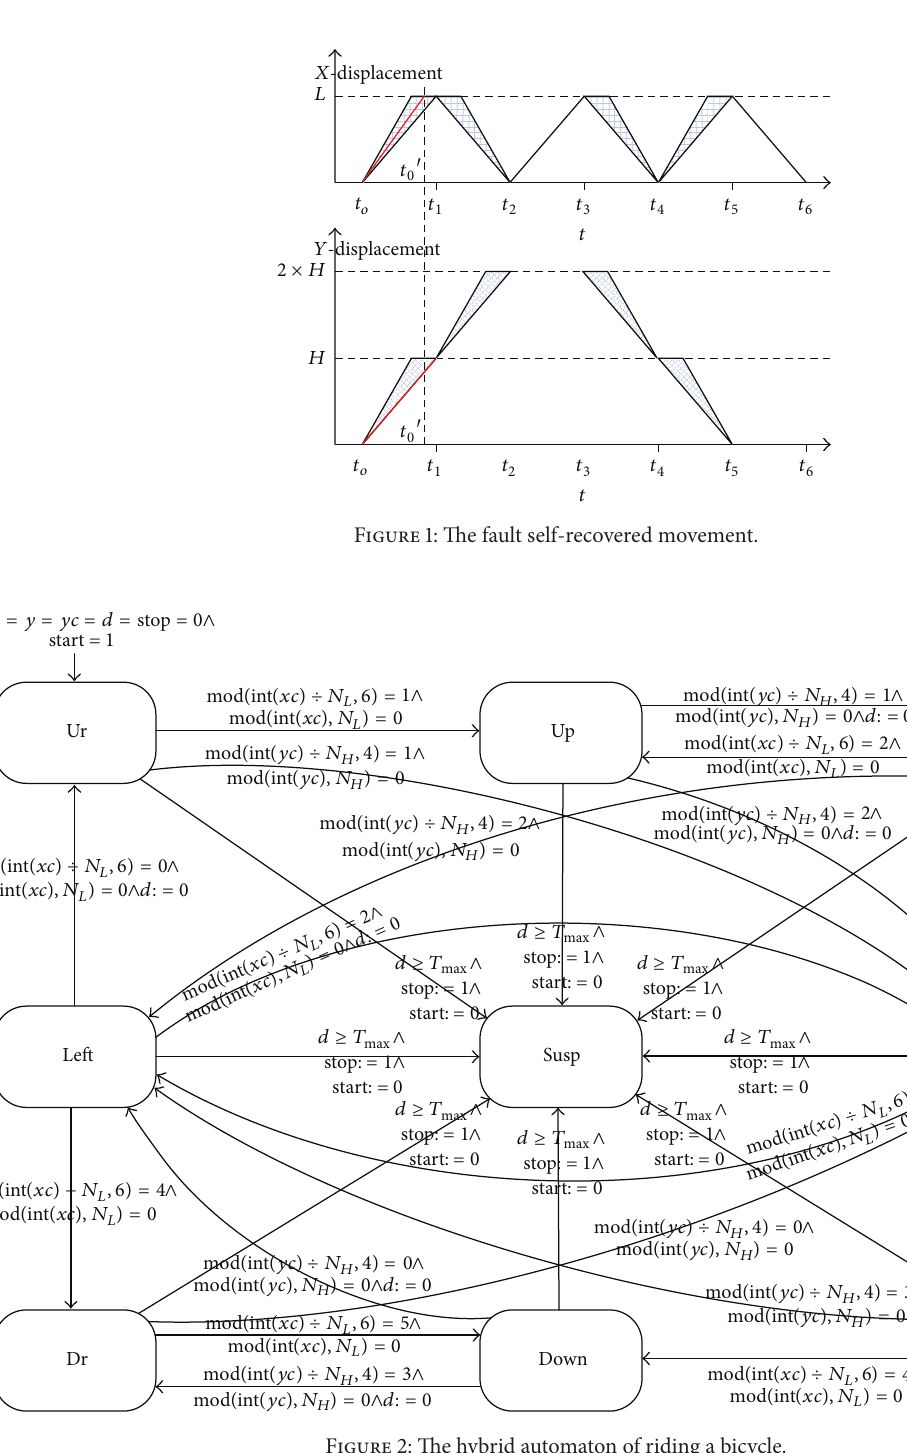
Figure 2: The hybrid automaton of riding a